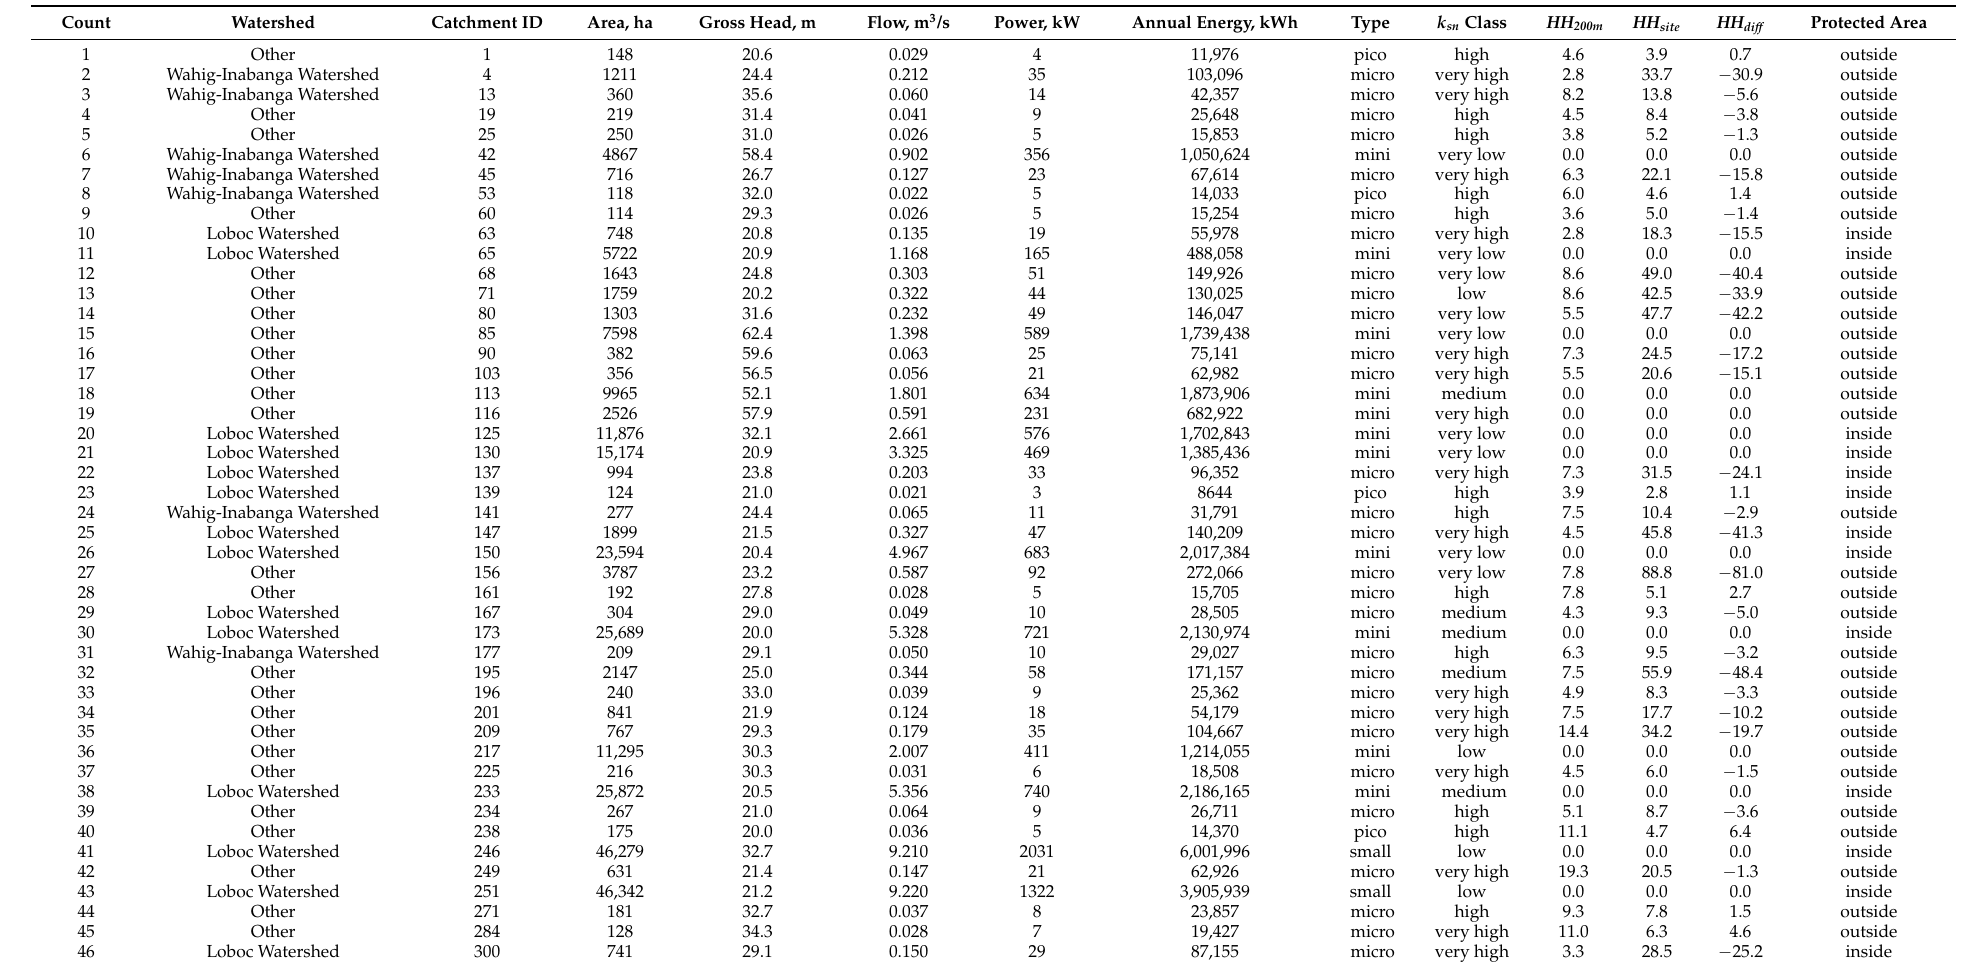
Table A1. List of potential small-scale hydropower sites identified in Bohol Island,